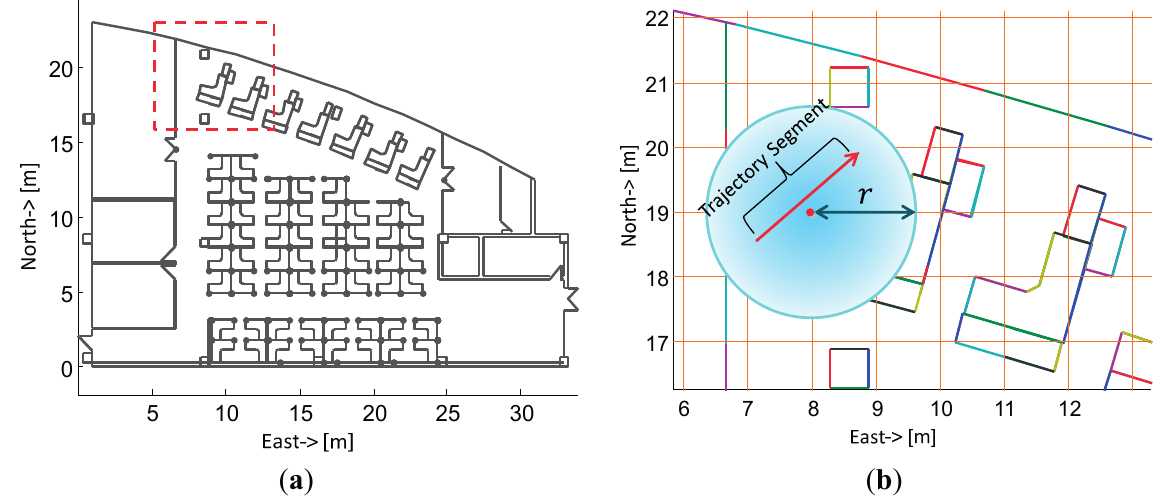
Figure 18. ( a ) The vector graph of an office building; ( b ) enlarged vector graph of marked box with red dotted line in ( a ) and the grids definition. Different segments of the vector graph are denoted by different